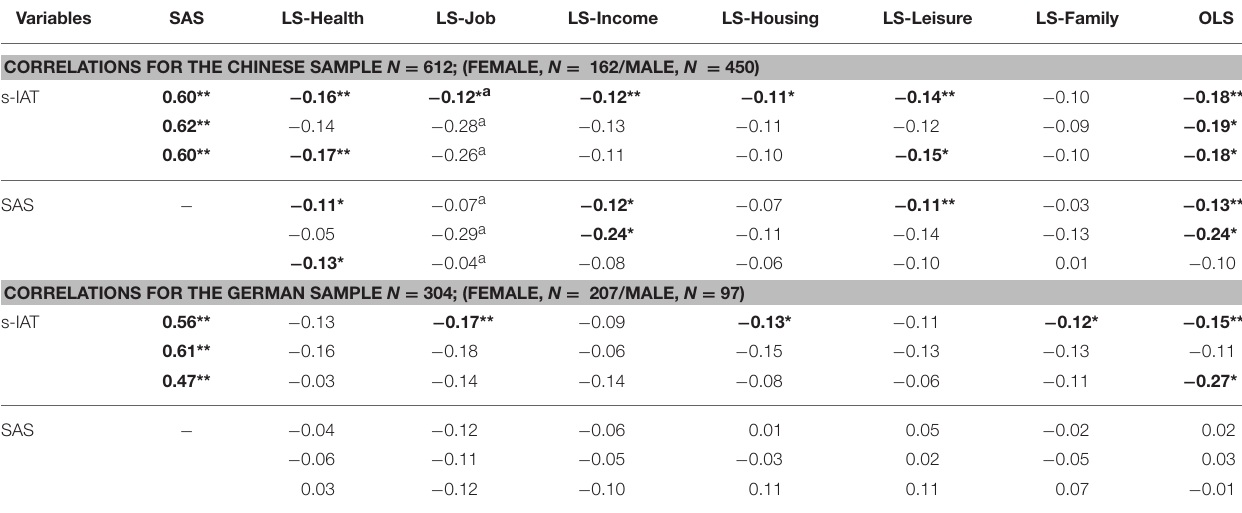
TABLE 3 | Partial correlations between digital use variables (s-IAT, SAS) and life satisfaction variables for the complete samples controlling for gender (top line). Correlations are also presented for each variable seperated by gender (female: middle line; male: bottom line). Variables SAS LS-Health LS-Job CORRELATIONS FOR THE CHINESE SAMPLE N = 612; (FEMALE, N = 162/MALE, N =